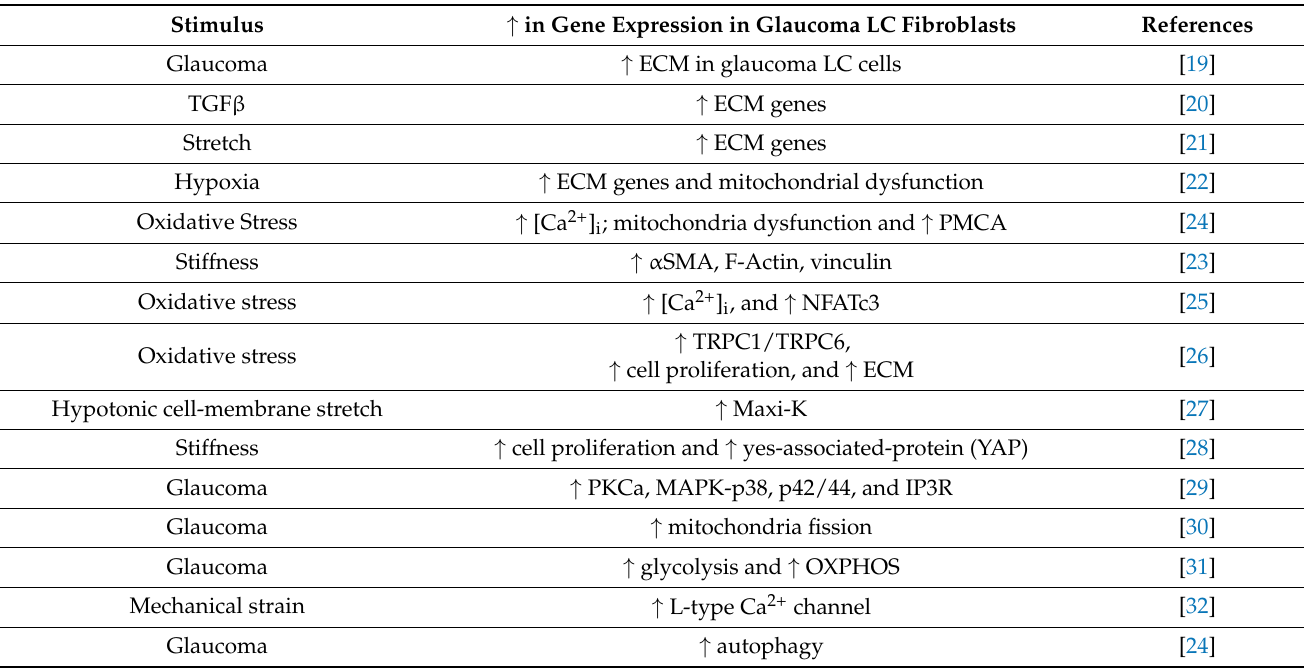
Table 1. Summary of dysfunctional intracellular Ca 2+ concentration, Ca 2+ entry and exit ion channels, Ca 2+ -related ECM genes and proteins, disturbed Ca 2+ -signalling pathways, and dysfunctional cell proliferation and autophagy in glaucomatous LC myofibroblasts obtained by the